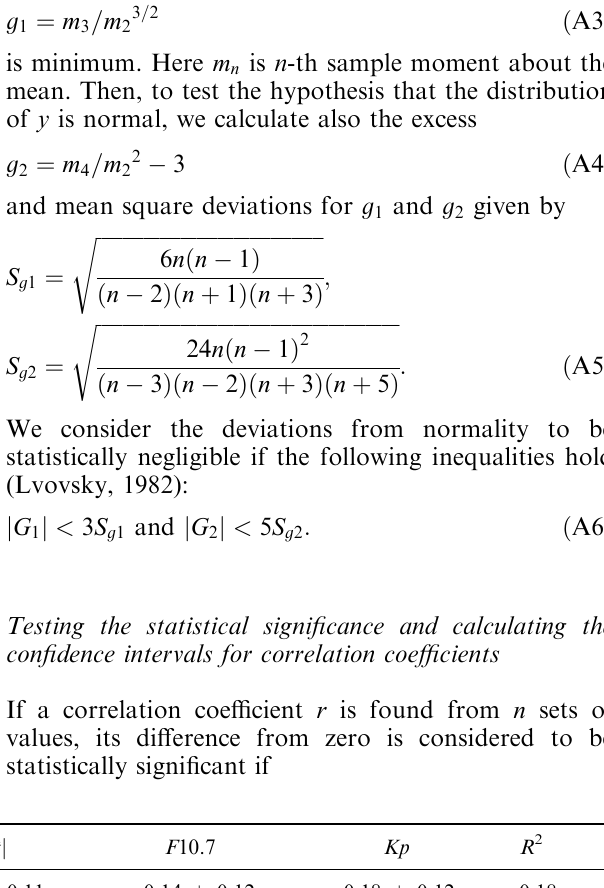
Table 8. Dependence of partial correlation coe(cid:129)cients on the storm intensity for the set of data satisfying the condition of Eq.